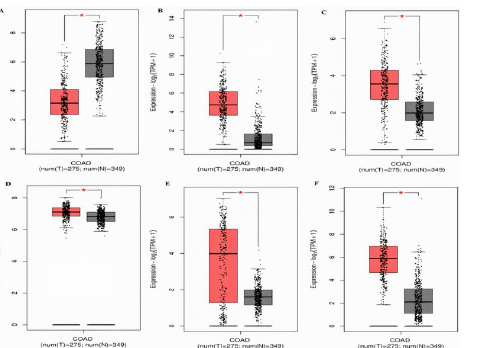
Fig 3. Box plots showing the relative mRNA expression levels of real hub genes in normal and COAD patients (Information retrieved via GEPIA database). The box plots shows the relative mRNA expression of: (A) CXCL12, (B) CXCL8, (C) AGT, (D) GNB1, (E) GNG4, and (F) CXCL1; in COAD patients and normal samples. A p-value of < 0.05 was considered